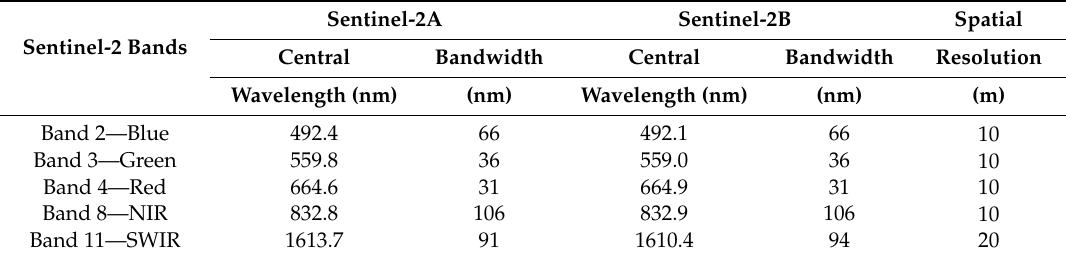
Table 1. Information of the Sentinel-2A and -2B bands used in this